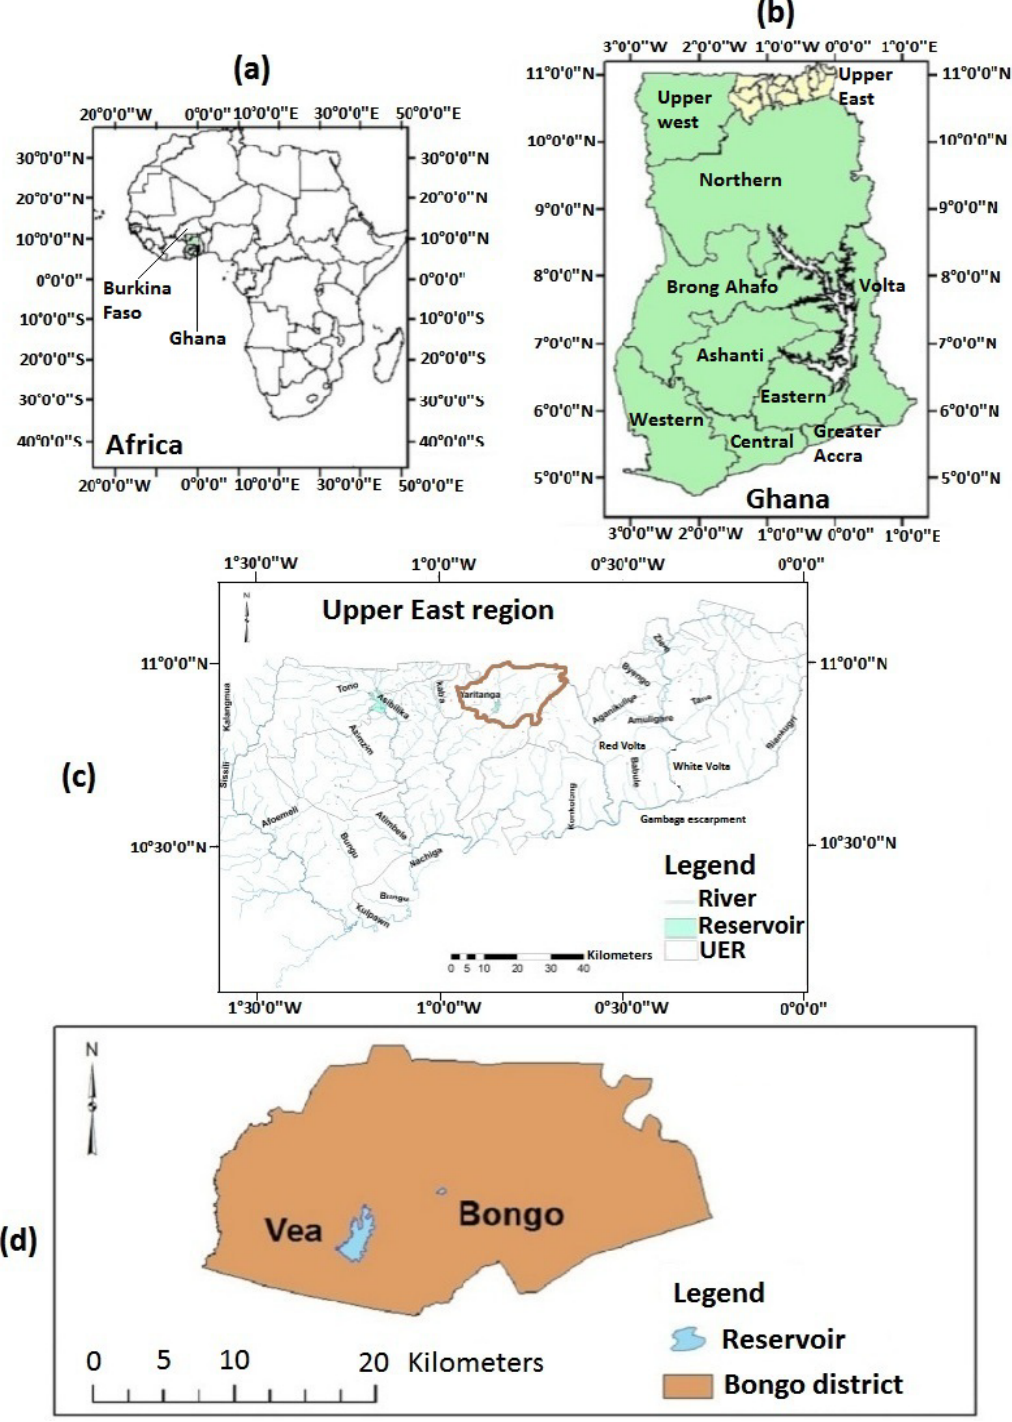
Figure 1. Location of Ghana in West Africa ( a ); the Upper East region (UER) of Ghana ( b ); hydrological network of the UER and location of the study area ( c ); and the study area including the Vea and Bongo reservoirs ( d ).